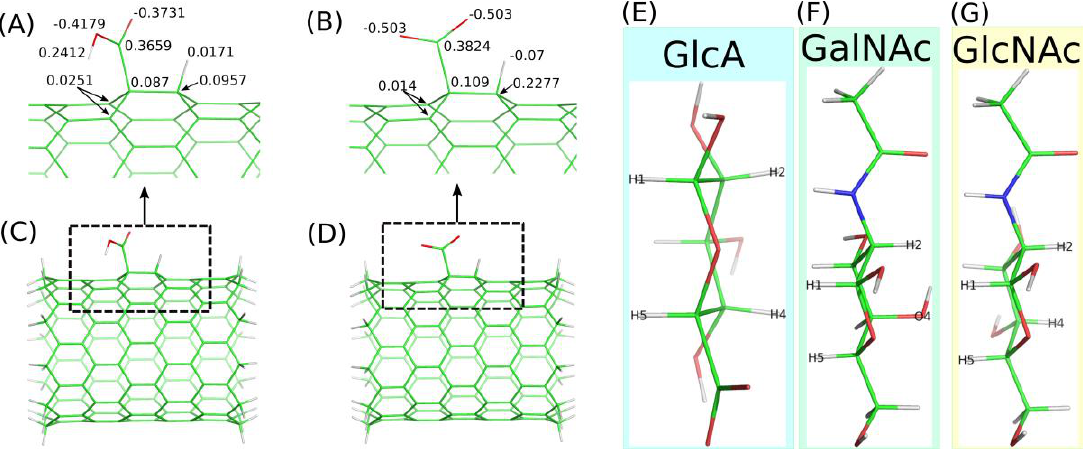
Figure 1. ( A , B ) show the schematic representation of fCNT with a carboxylic acid or a carboxylate (COOH and COO ⊖ ), respectively. The topology of bonds formed after grafting the functional groups into the CNT structure, and atomic charges on atoms involved in the CNT functionalization are showed. ( C , D ) show small (10,0) CNT clusters with COOH and COO ⊖ , respectively, used in quantum mechanics computation and RESP atomic charges derivation using B3LYP/6-31G(d) implemented in RED Server Development. Green sticks represent carbon atoms, red ones oxygen atoms, and grey ones hydrogen atoms. ( E – G ) show stick representations of monosaccharides involved in this study together with labels on the atoms, which help to define spatial orientation of a given molecule in reference to the fCNT surface (atom numbering remains in accordance with IUPAC recommendations).